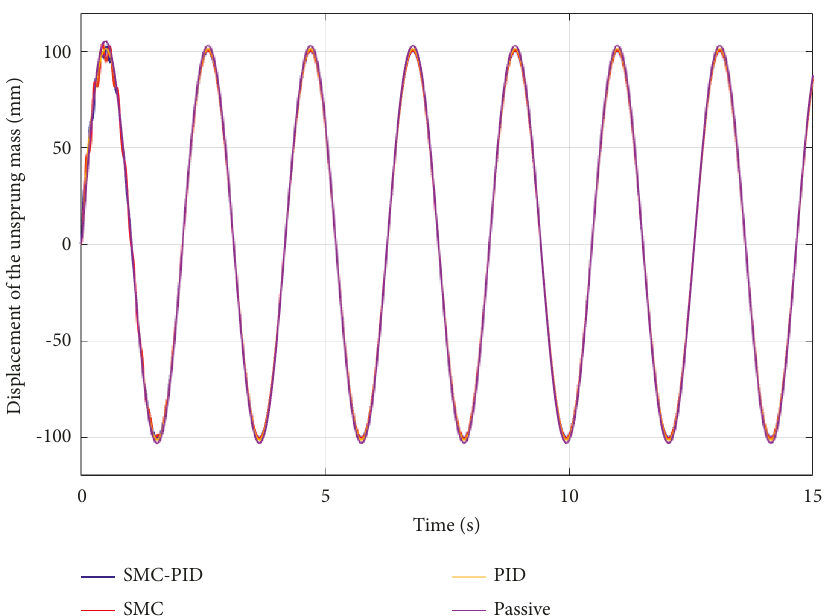
Figure 10: Displacement of the un-sprung mass (Case 2).